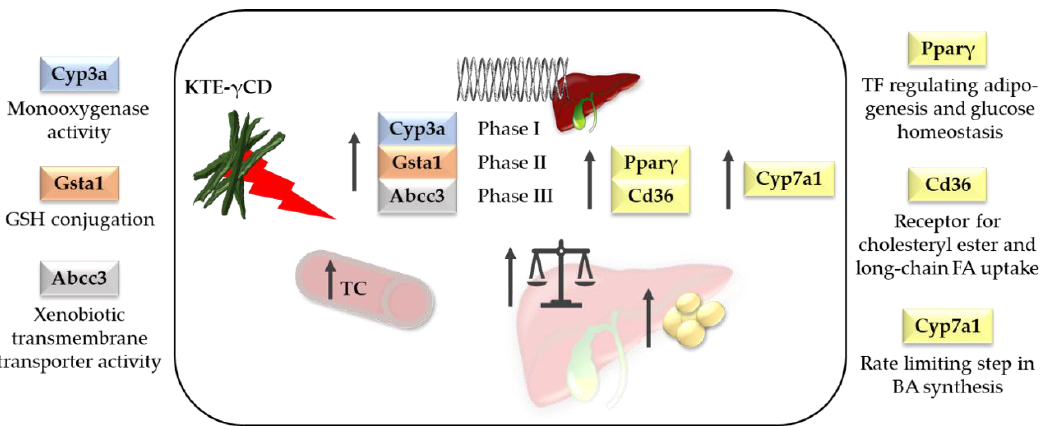
Figure 9. Safety aspects of a high dietary Kuding tea extract encapsulated in γ -cyclodextrin (KTE- γ CD). KTE- γ CD supplementation in mice induced hepatic xenobiotic-metabolising enzymes and increased liver mass accompanied by enhanced hepatic lipid accumulation. Abcc3, ATP-binding cassette, subfamily C, member 3; BA, bile acid; Cd36, CD36 molecule; Cyp3a, cytochrome P450, family 3, subfamily a; Cyp7a1, cytochrome P450, family 7, subfamily a, polypeptide 1; FA, fatty acid; GSH, glutathione; Gsta1, glutathione S-transferase, alpha 1; Ppar γ , peroxisome proliferator-activated receptor gamma; TC, total cholesterol; TF, transcription factor [9].